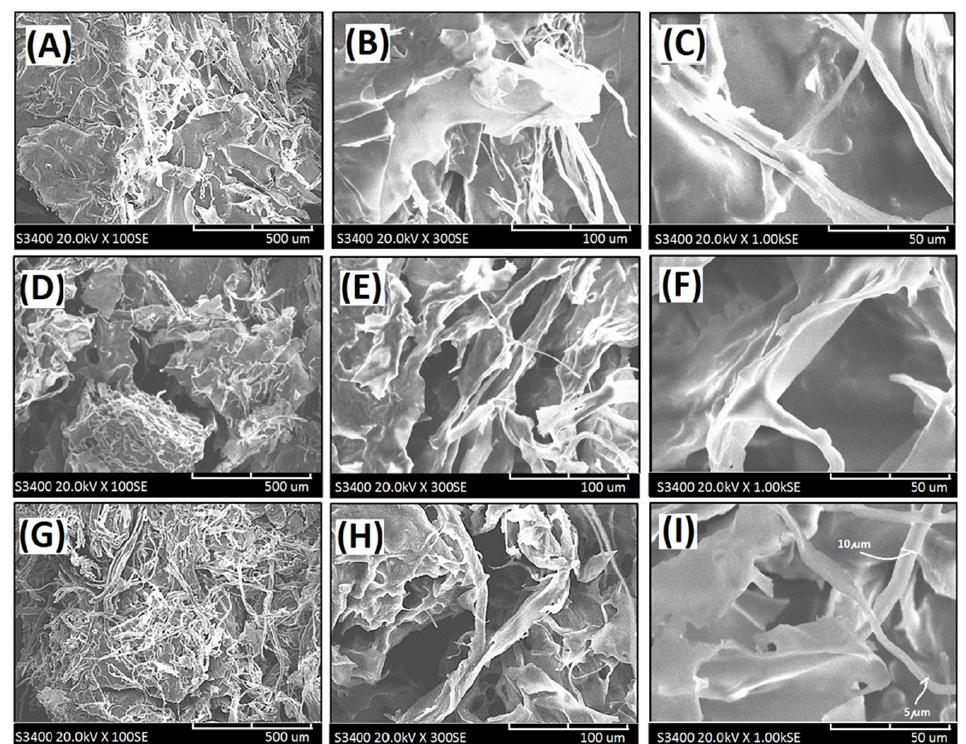
Figure 4. Scanning electron micrographs of the cross-linked composite foam materials (CFM) with decellularized elastic cartilage microscaffolds: ( A ) PCFM1N (100×), ( B ) PCFM1N (300X), ( C ) PCFM1N (1000×), ( D ) PCFM2N (100×), ( E ) PCFM2N (300×), ( F ) PCFM2N (1000×), ( G ) PCFM3N (100×), ( H ) PCFM3N (300×), and ( I ) PCFM3N (1000×).